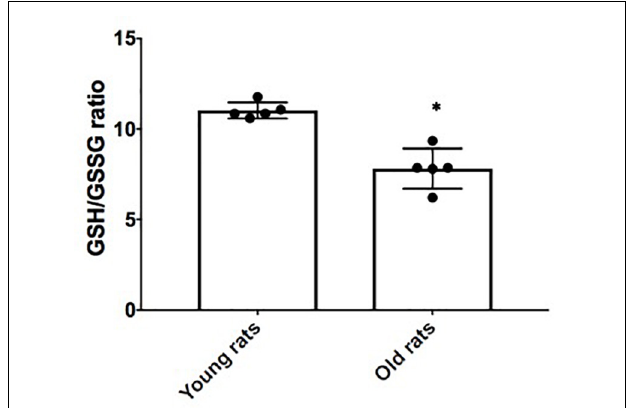
FIGURE 6 | Redox state in the cerebral cortex (Cx) from young and old rats. Reduced glutathione/oxidized glutathione (GSH/GSSG) ratio was determined by using the proteins isolated from young (4 months old) and old (24 months old) rats as described in the methodology. Each bar represents the mean ± SE of three independent experiments. Statistical significance with respect to young rats ∗ p ≤